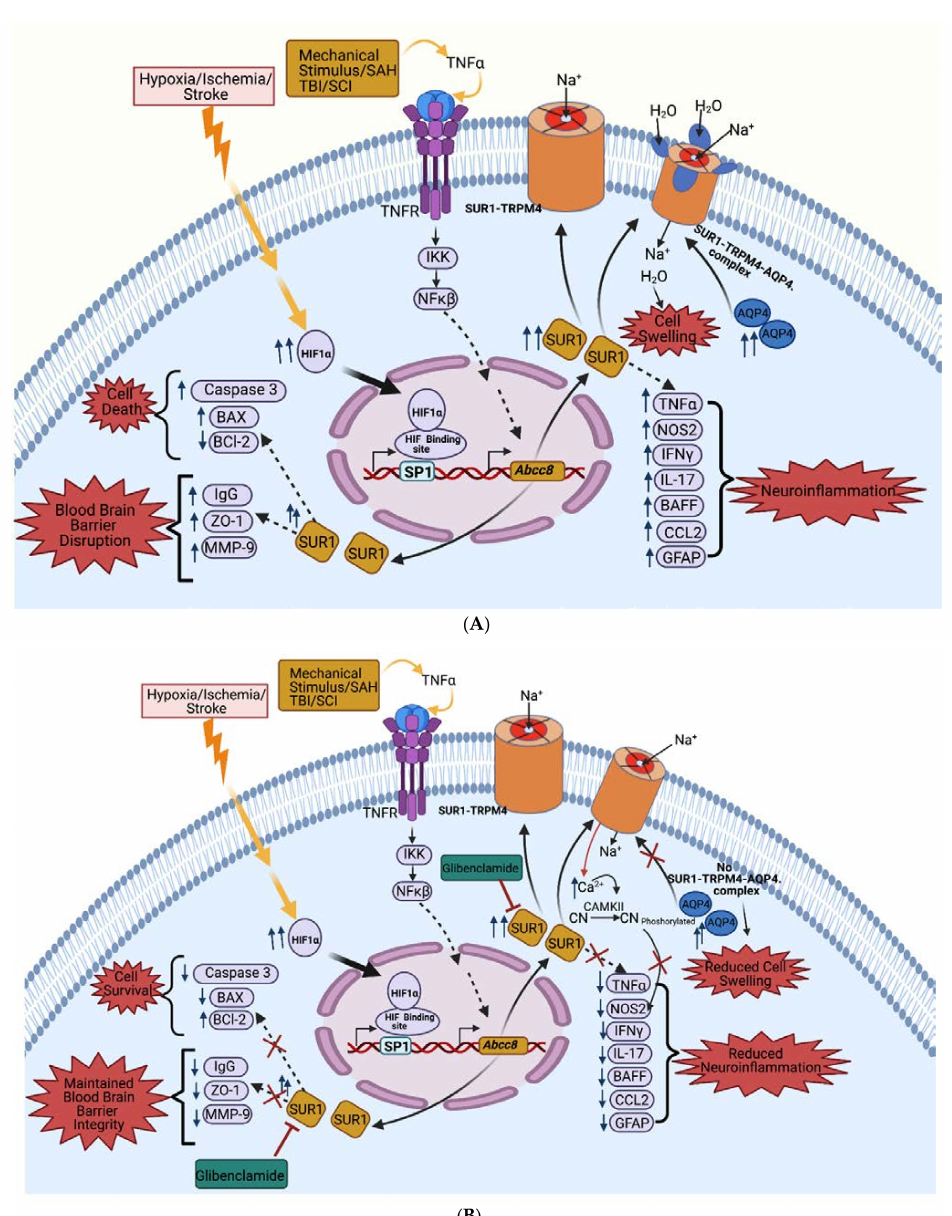
Figure 3. ( A ) Schematic depiction of upregulated pathways after CNS injury related to SUR1-TRPM4. Hypoxia/ischemia results in upregulation of HIF1 α , which is transported to the nucleus where it binds with the HIF-binding site, leading to the upregulation of SP1—which in turn leads to the upregulated transcription of Abcc8 (SUR1). Mechanical stimuli after traumatic brain injury or spinal cord injury results in increased levels of TNF α , which is an upstream regulator of Abcc8 (SUR1). Increased levels of TNF α lead to upregulation of IKK and NF- κ B, ultimately resulting in transcriptional activation of Abcc8 (SUR1). Upregulation of SUR1 leads to increased association of SUR1-TRPM4 on the plasma membrane. An open SUR1-TRPM4 channel results in Na + influx, leading to depolarization and an oncotic gradient. Association of the SUR1-TRPM4-AQP4 complex results in increased influx of water into the cell (following the oncotic gradient), ultimately leading to cell swelling. Increased SUR1 may contribute to neuroinflammation (by activating NOS2, INF γ , IL-17, BAFF, CCL2, GFAP), disruption of the blood brain barrier (by activating IgG, MMP-9 and ZO-1), and cell death (via upregulation of caspase 3 and BAX). ( B ) Schematic representation of the signaling effects of SUR1 inhibition via genetic Abcc8 knockout or pharmacological inhibition by glibenclamide. Edema is reduced via channel blockade. Neuroinflammation is decreased (lower levels of TNF α , NOS2, INF γ , IL-17, BAFF, CCL2, GFAP); the blood–brain barrier disruption is minimized (downregulated ZO-1, MMP-9), and cell death reduced (upregulation BCL-2, downregulation of BAX and caspase 3). Figure created with BioRender.com